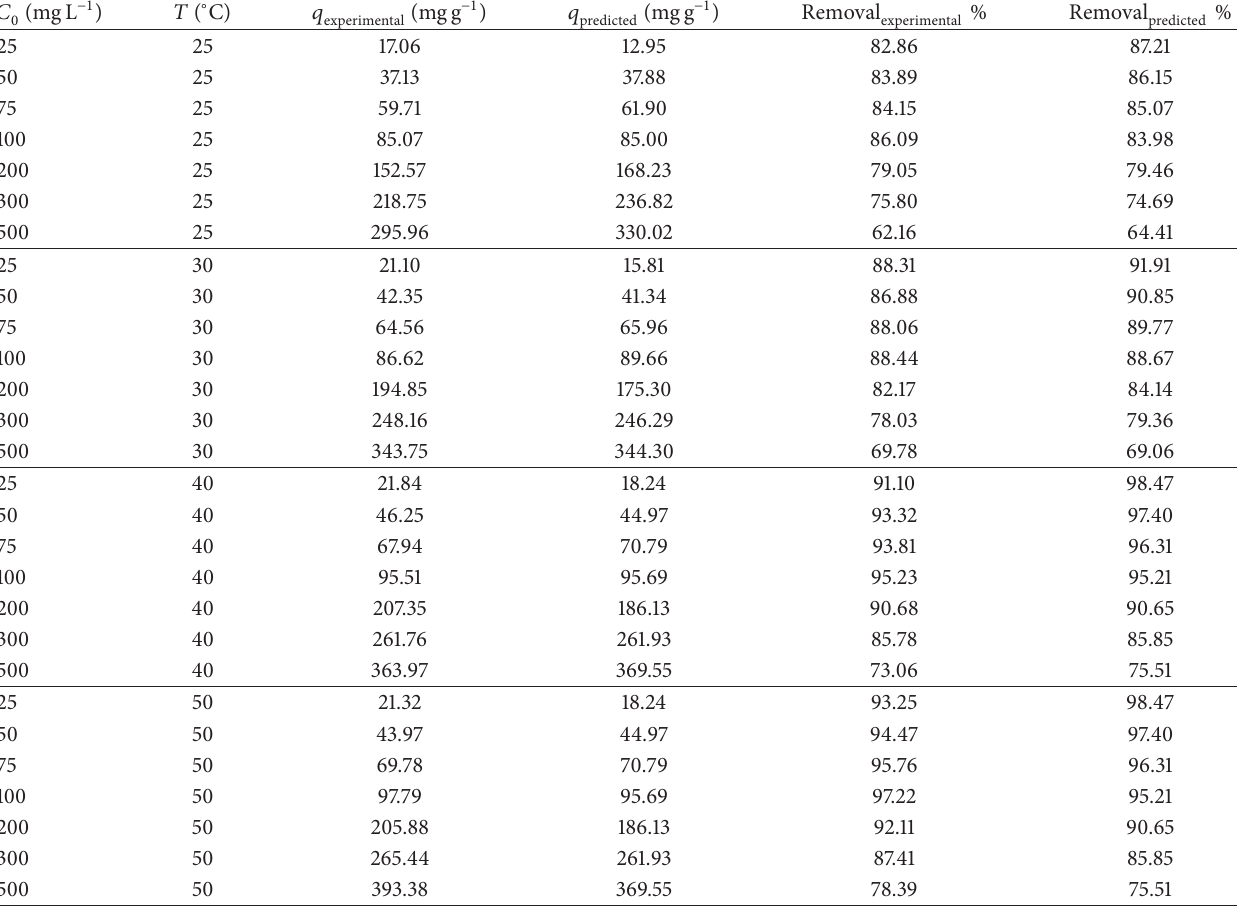
Table 7: Experimentally determined and predicted 𝑞 and removal % values at different concentration-temperature combinations to assess the accuracy of the model.